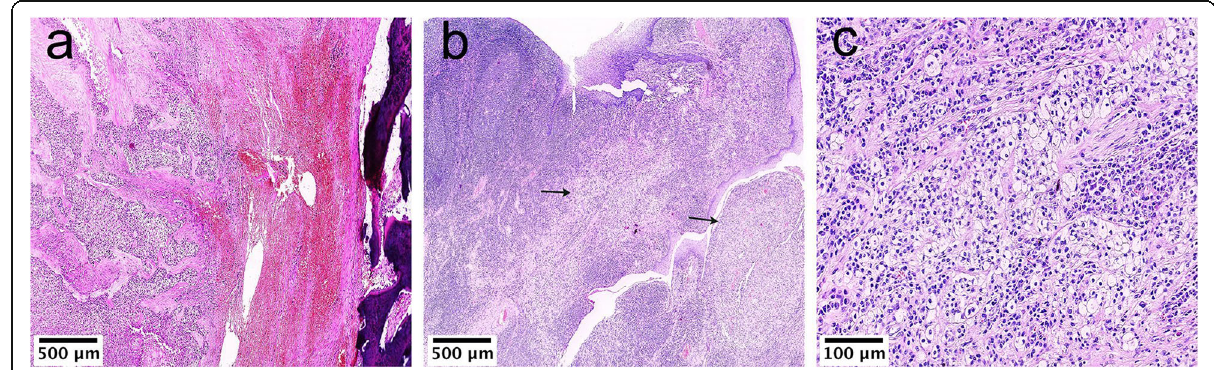
Fig. 4 Uncommon stromal alterations in CCC. ( a ) Stromal hemorrhage (Case 4, HE× 50). ( b , c ) Lymphoid infiltration around the tumor nests (the arrows indicate tumor cells) (Case 3, HE× 50 and HE×